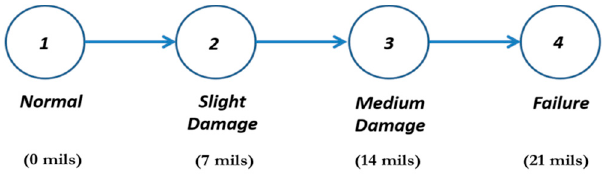
Table 2. Confusion or observation matrix.